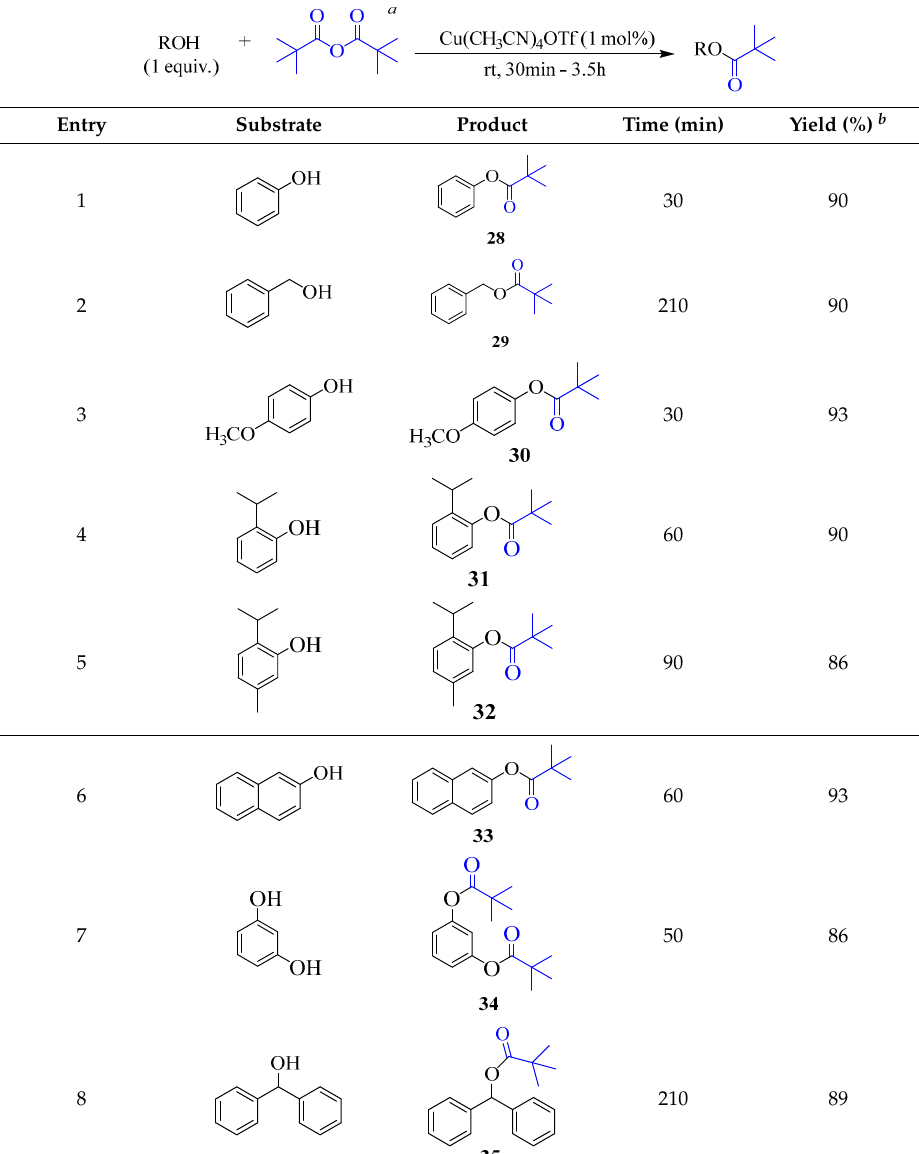
Table 3. Pivalation of alcohols catalyzed by Cu(CH 3 CN) 4 OTf.